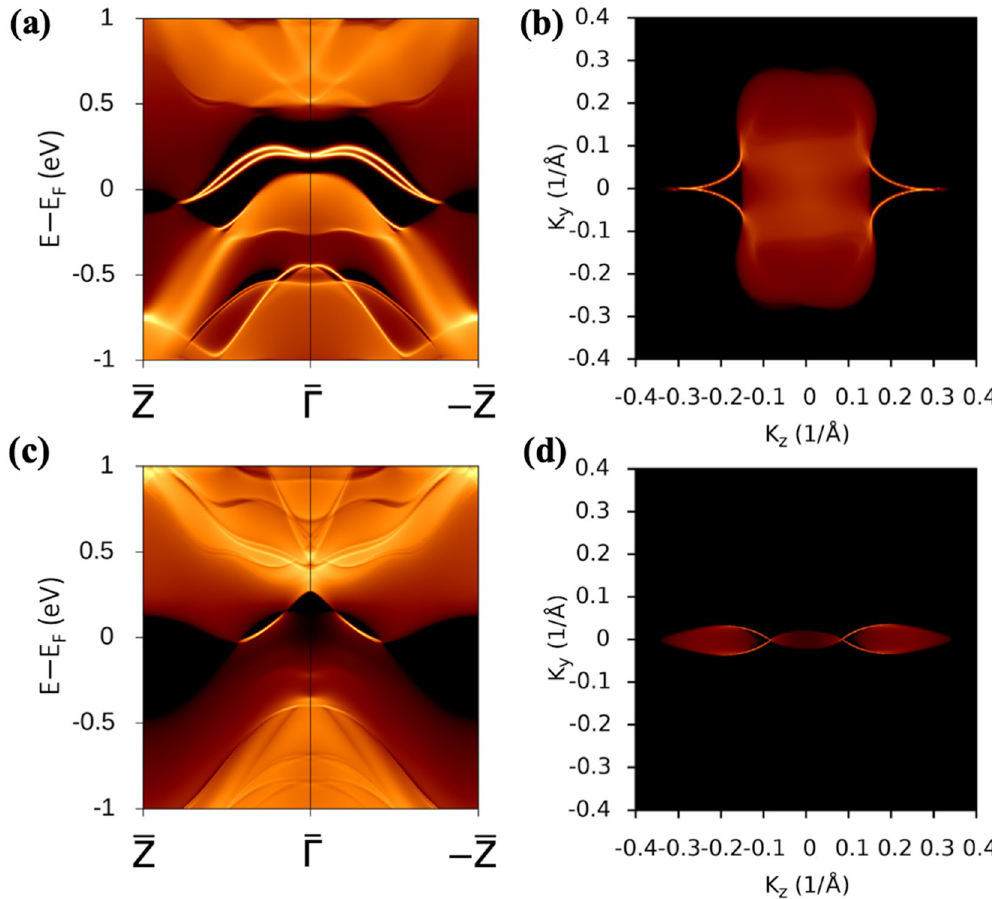
Figure 4. Bulk ( a ) CaCd 2 Bi 2 and ( c ) CaCd 2 SbBi surface states projected on (100) plane under HSE06 with SOC. 2D Fermi arcs for ( b ) CaCd 2 Bi 2 and ( d ) CaCd 2 SbBi at the E−E F = −0.1 eV and 0.1 eV,